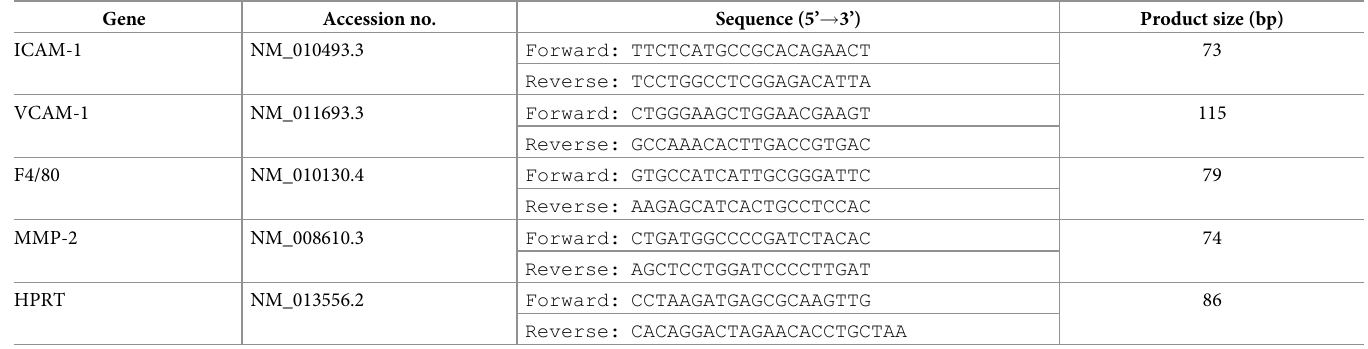
Table 1. Primer sequences for semi-quantitative real-time PCR.